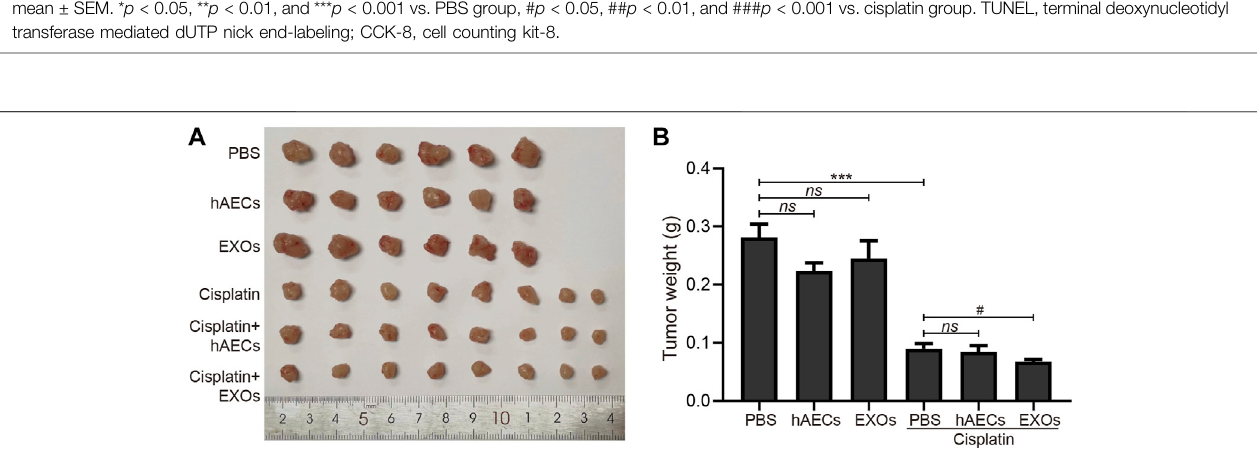
FIGURE 5 | Effects of hAECs and EXOs on the tumor growth in nude mice with A549 NSCLC. (A) The gross tumor images in different groups of nude mice with A549 NSCLC on day 12 after cisplatin injection. (B) Comparison of tumor weights in different groups of nude mice with A549 NSCLC on day 12 after cisplatin injection. Data are shown as mean ± SEM. *** p < 0.05 vs. PBS group, # p < 0.05 vs. cisplatin group. NSCLC, non-small cell lung